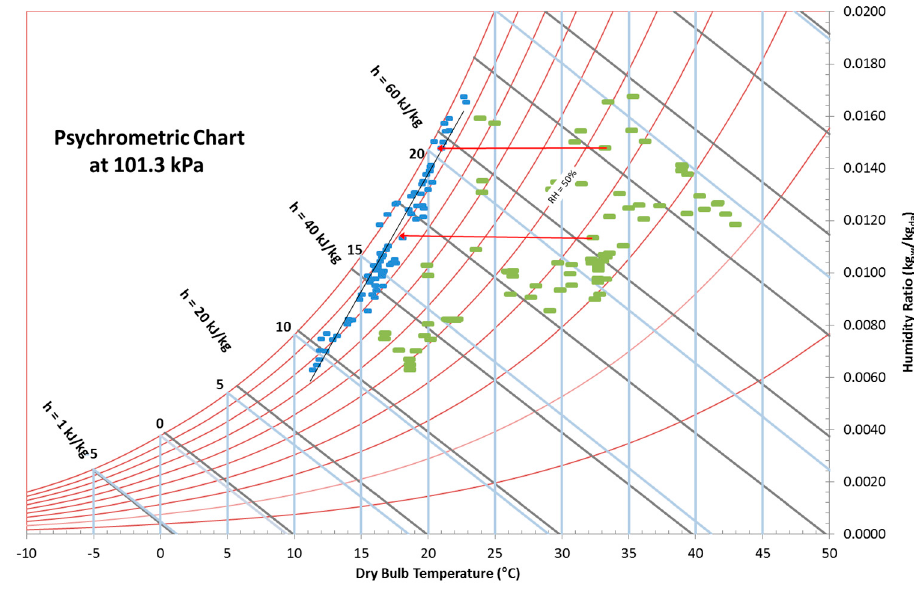
Figure 8. Air cooling zone of the DPC on a psychrometric chart. Test conditions—air volumetric flow rates up to 3.8 m 3 · s − 1 .